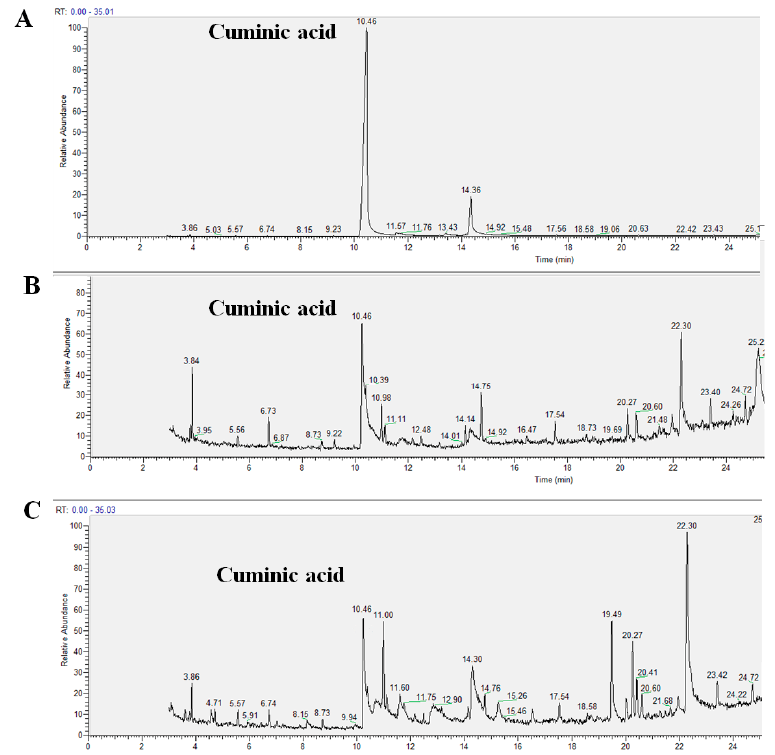
Figure 3. Detection of cuminic acid by HPLC. ( A ) Standard sample of cuminic acid; ( B ) cuminic acid in cucumber leaves from soil by irrigation; and ( C ) cuminic acid in cucumber roots from leaves by spraying.